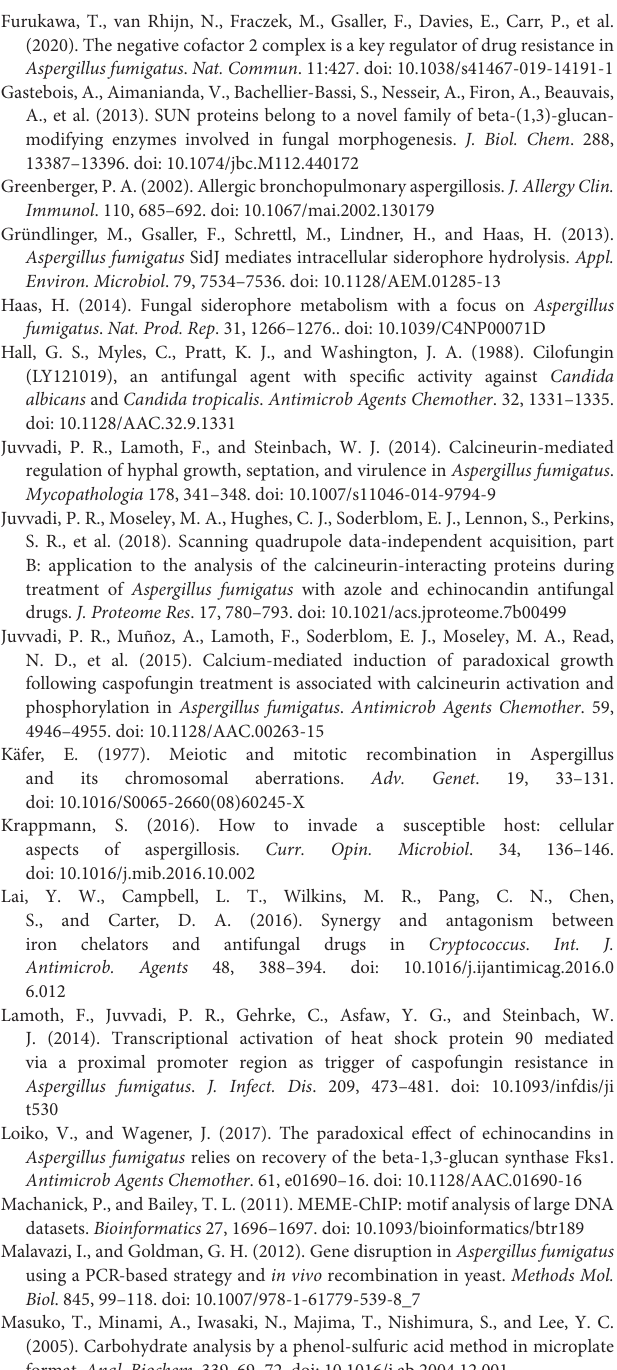
Supplementary Table 1 | Binding of ZnfA:3xHA to target genes that are shared between the control and caspofungin conditions (common), unique to the control